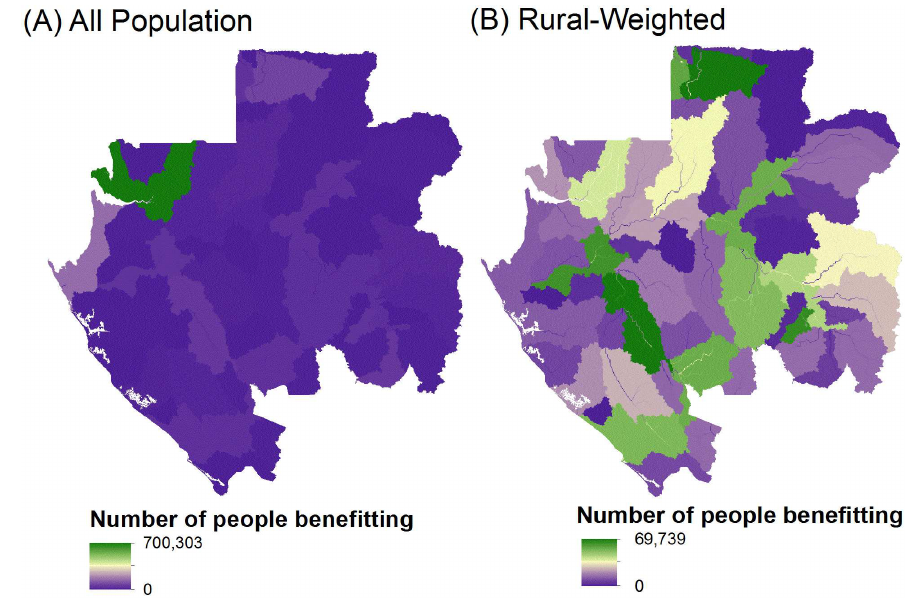
Fig 3. Servicesheds for erosion control, nitrogen retention, and phosphorus retention weighted by downstream beneficiary population size. (A) “All population”serviceshed. (B) “Rural-weighted” serviceshed. Pixel values represent the numberof downstreampeoplewithin each serviceshedthat would benefit from a watershedconservation activity on that pixel. Therefore, pixels with the highestvalues are those with the largest